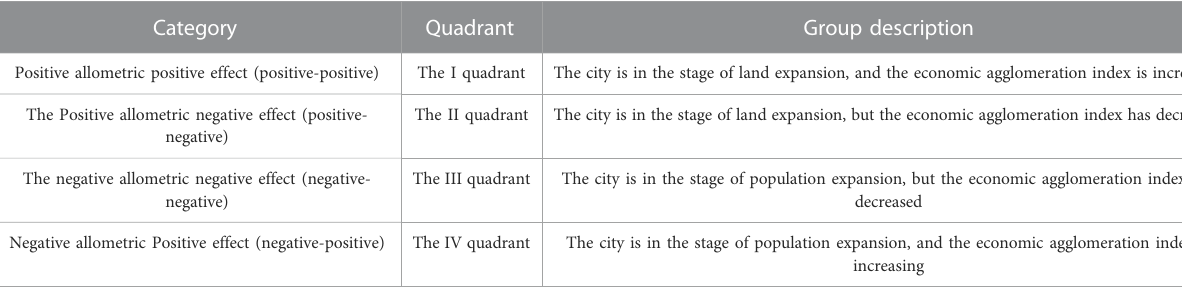
TABLE 5 Grouping category and basis of economic agglomeration effect of allometric